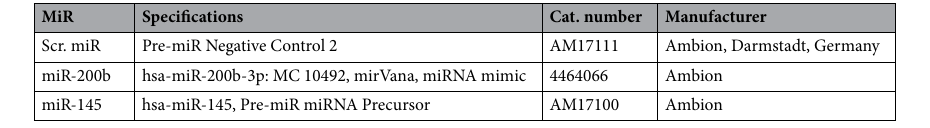
Table 1. MicroRNAs used in the